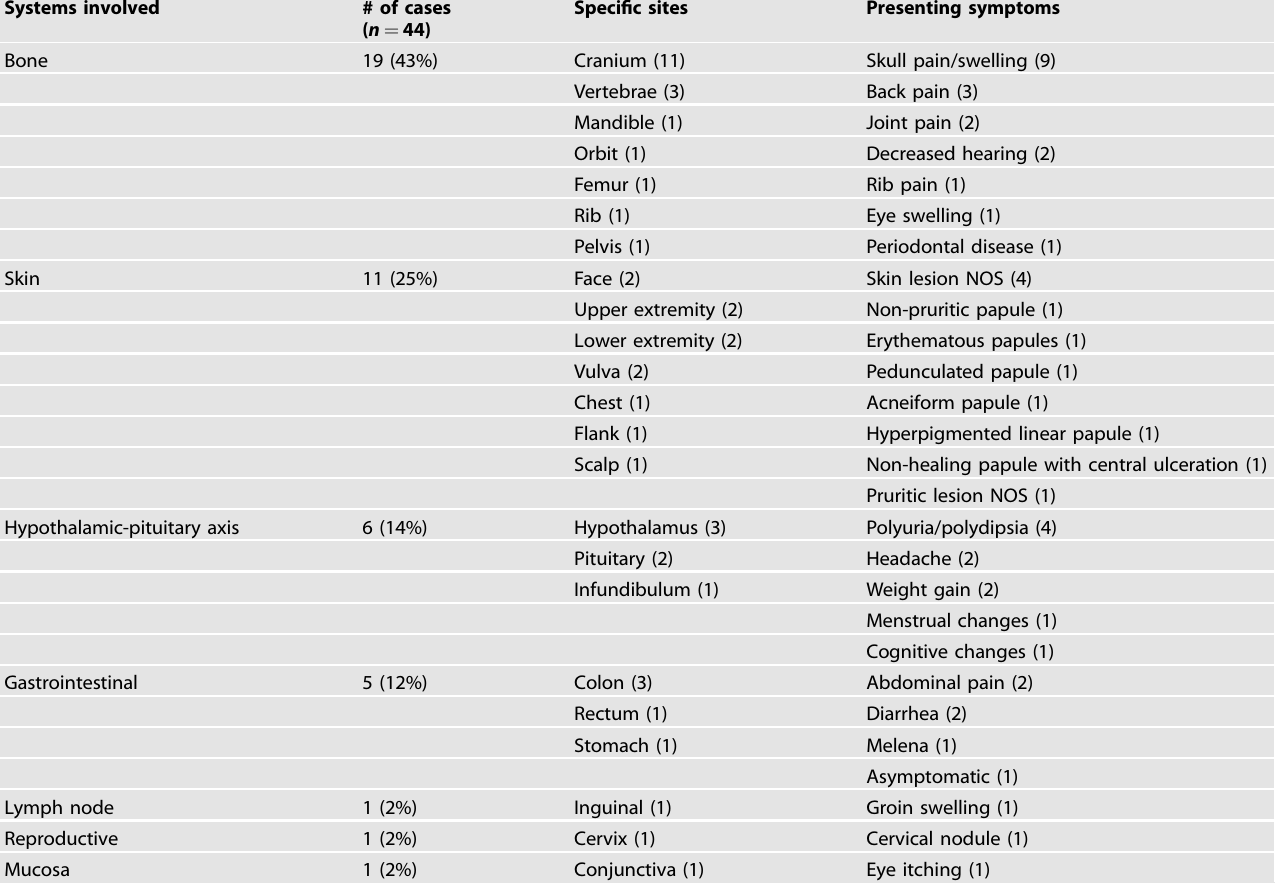
Table 1. Organ involvement and presenting symptoms at diagnosis in unifocal adult Langerhans cell histiocytosis. Systems